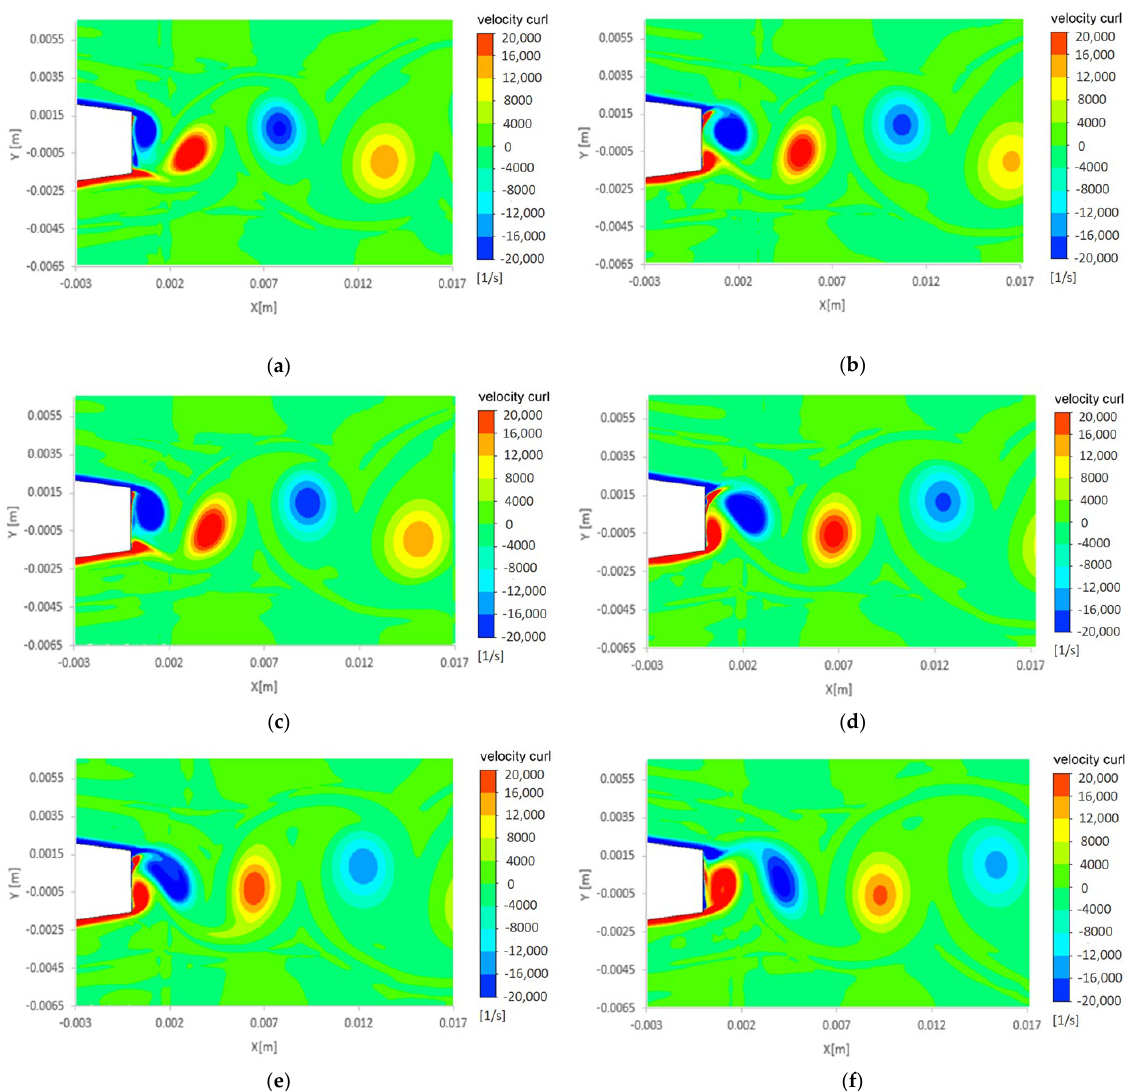
( a , b ), ( c , d ), and ( e , f ) regimes at t/T = 0 ( a , c , e ) and t/T = 0.25 = 2 ( a , b ), σ = 0.98 ( c , d ), and σ = 0.69 ( e , f ) regimes at t / T = 0 ( a , c , e ) and t / T = 0.25 ( b , d , f σ i σ i σ i 𝜎𝜎 𝜎𝜎 𝜎𝜎 𝜎𝜎 𝑖𝑖 = 2 𝜎𝜎 𝑖𝑖 = 0.98 𝜎𝜎 𝑖𝑖 = 0.69